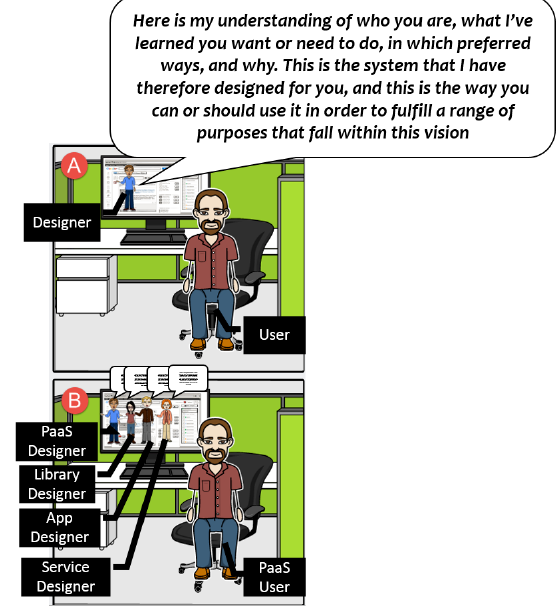
Fig. 3. The system as the designer’s proxy (A) and different designers communicating with the user at interaction time